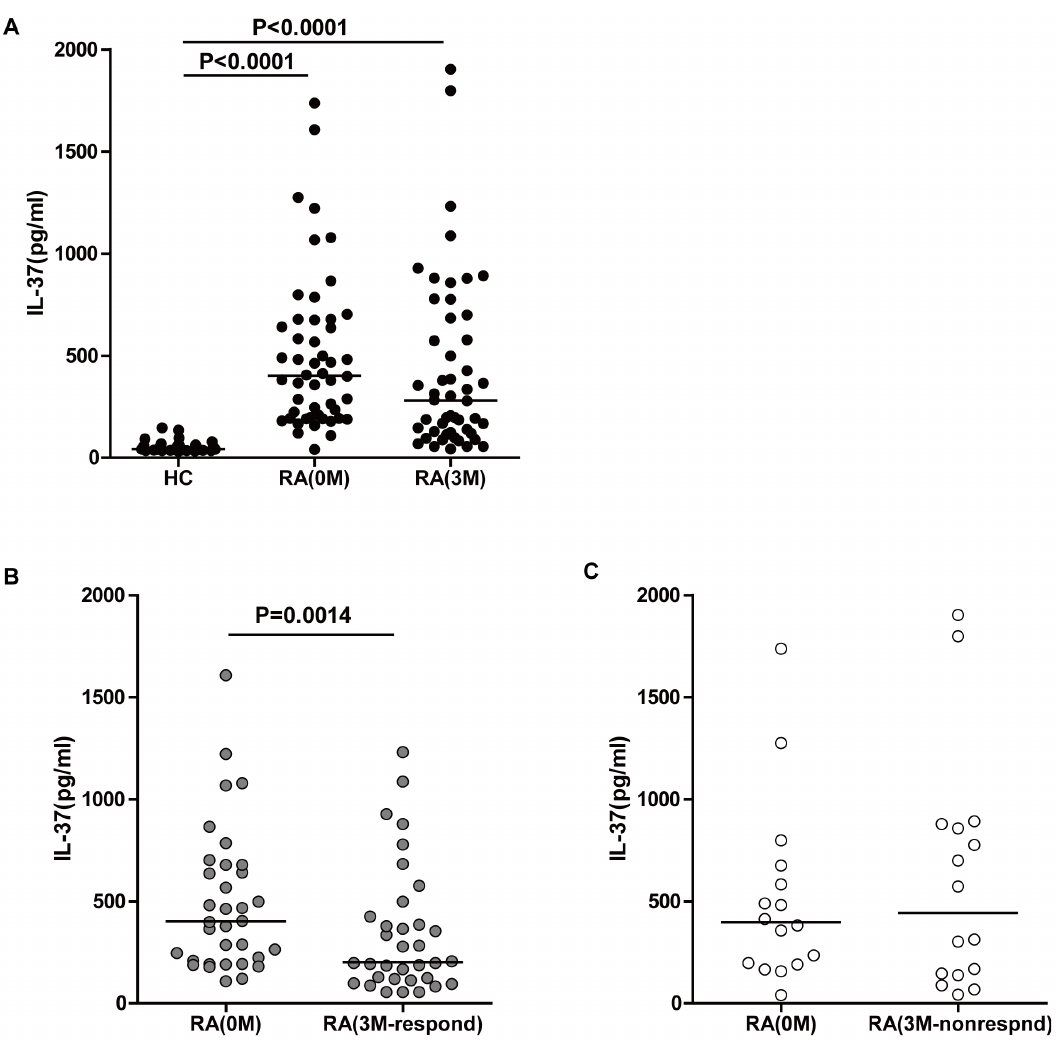
Figure 1. Plasma levels of IL-37 in RA patients. ( A ) Plasma levels of IL-37 in HCs and the total RA patient cohort at baseline, and after three months of DMARD treatment. ( B ) Plasma levels of IL-37 in drug responders compared to the same patients at baseline (grey dots). ( C ) Plasma levels of IL-37 in drug non-responders compared to the same patients at baseline (white dots). The horizontal lines indicate the median values of the different groups. The difference between the groups was analyzed by Mann-Whitney test and Wilcoxon signed rank tests for unpaired and paired comparisons, respectively.